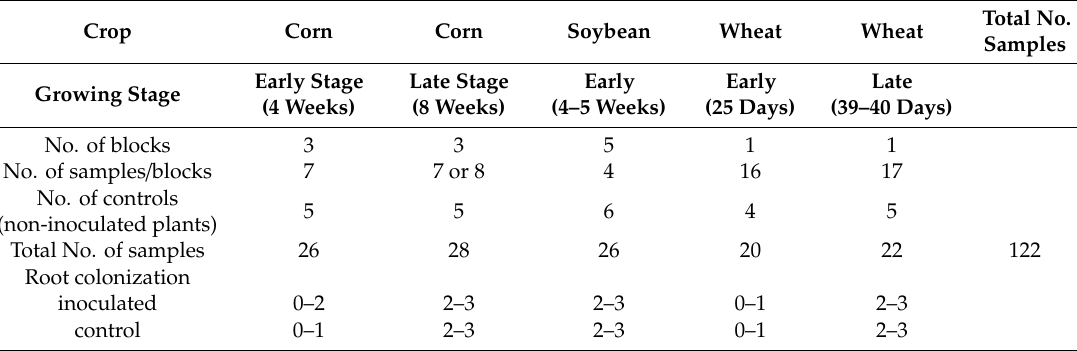
Table 1. Sampling design and root colonization